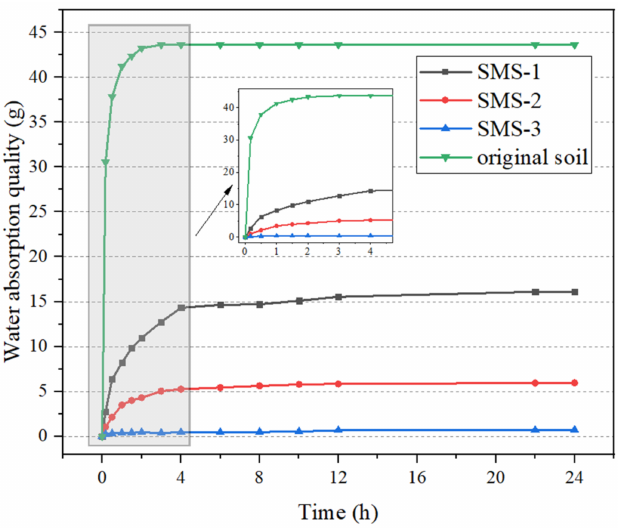
Figure 6. Group A capillary water absorption test results.